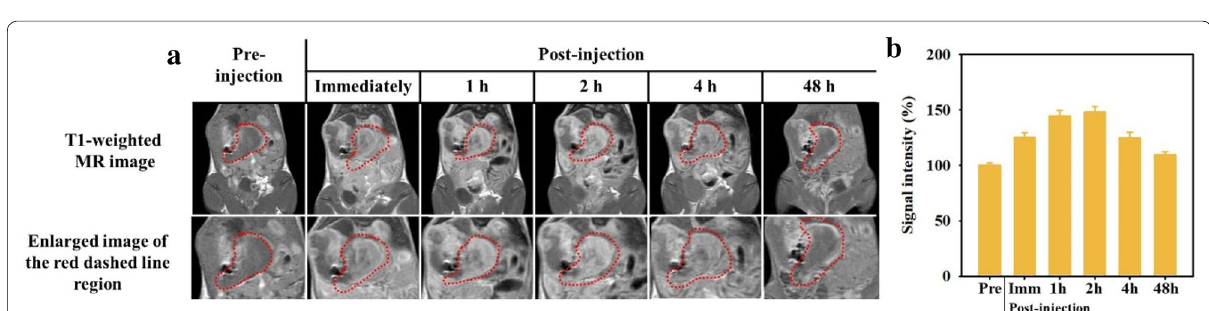
Fig. 8 a In vivo T1‑weighted MR images and b their relative T1 signal intensity (%) (red dashed line region) of orthotopic gastric cancer mice model after intravenous injection of MnOExHo (200 μg Mn per mouse) at different time points (pre‑injection, immediately after, and 1, 2, 4, and 48 h